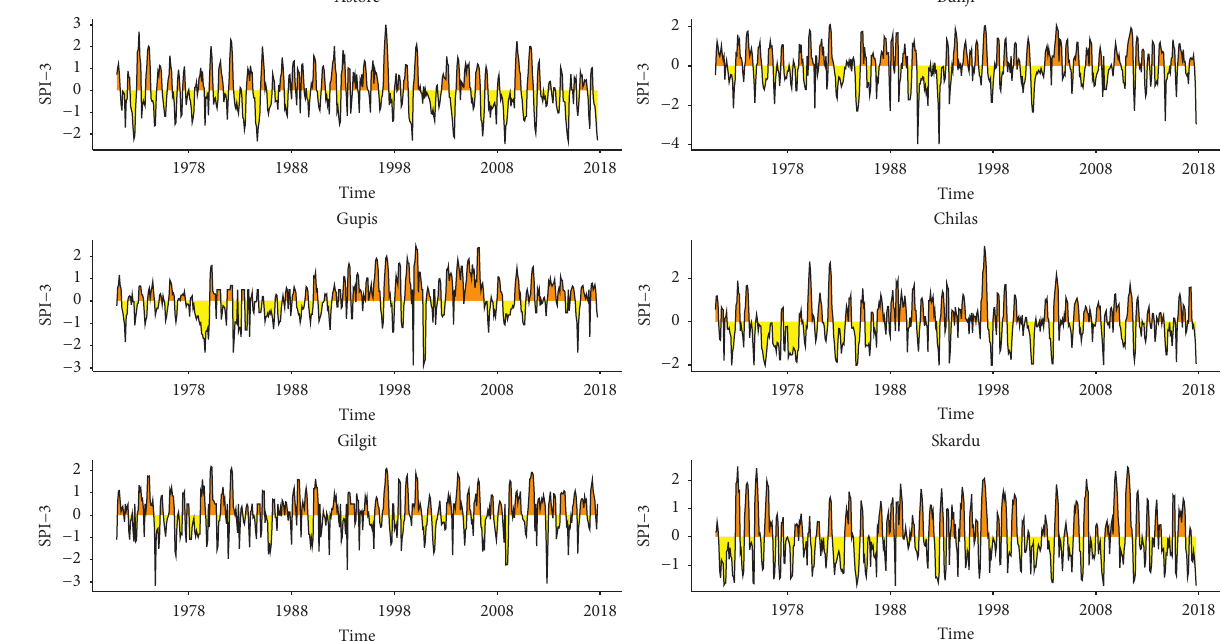
Figure 3: The temporal plots for SPI-3 at selected